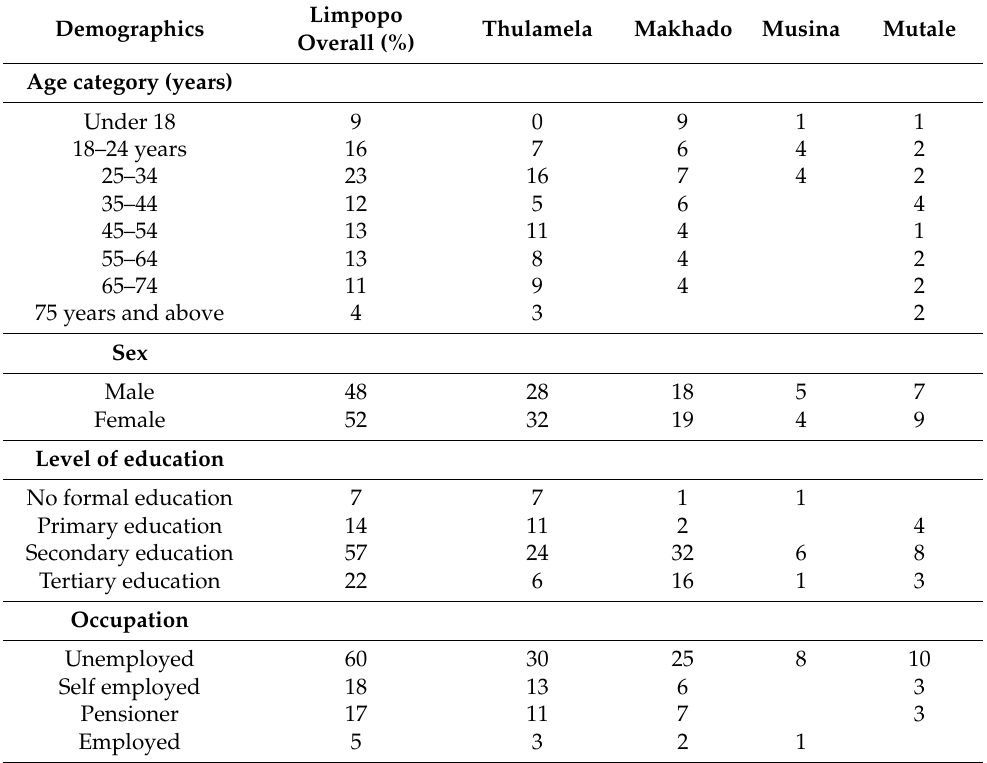
Table 3. Demographic information of the respondents in four local municipalities in the Vhembe district, Limpopo province ( n =